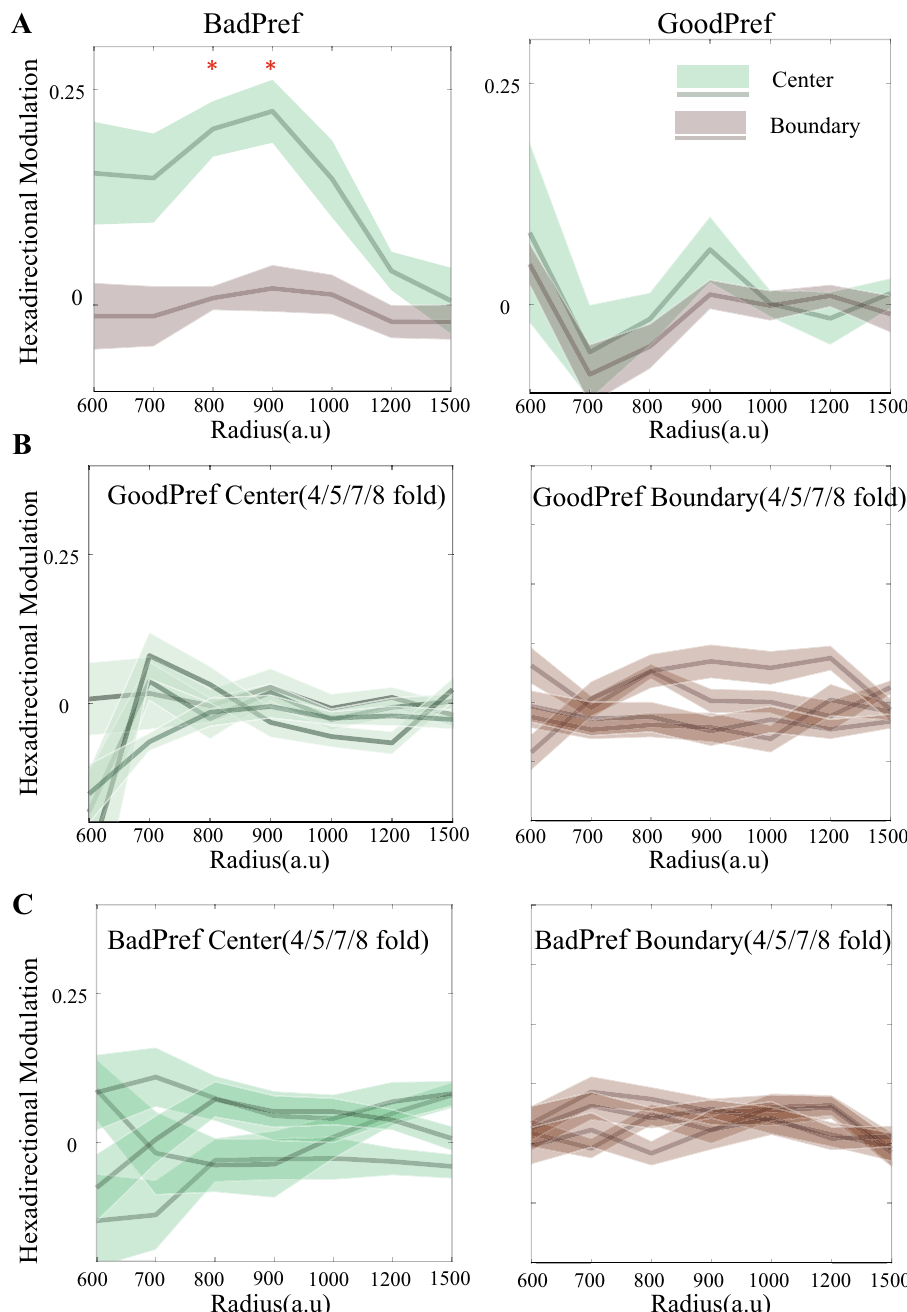
Figure 5. Analysis of symmetric rotational modulation using different partitioning radii. ( A ) For sixfold modulation, the BadPerf group shows a significant difference when the dividing radius of the boundary region and central region is 800–900 virtual units ( t test, p < 0.001), while GoodPerf shows no significance for all the partition radius ( t test, p > 0.05). ( B ) For the GoodPerf group, the modulation of other rotation symmetries (4/5/7/8-fold) is not significant ( t test, p > 0.05) in the central area (left panel) and the boundary area (right panel). ( C ) For the Boodobj group, the directional modulation of the 4/5/7/8-fold rotational symmetry is also not significant ( t test, p > 0.05) in the central area (left panel) and the boundary area (right